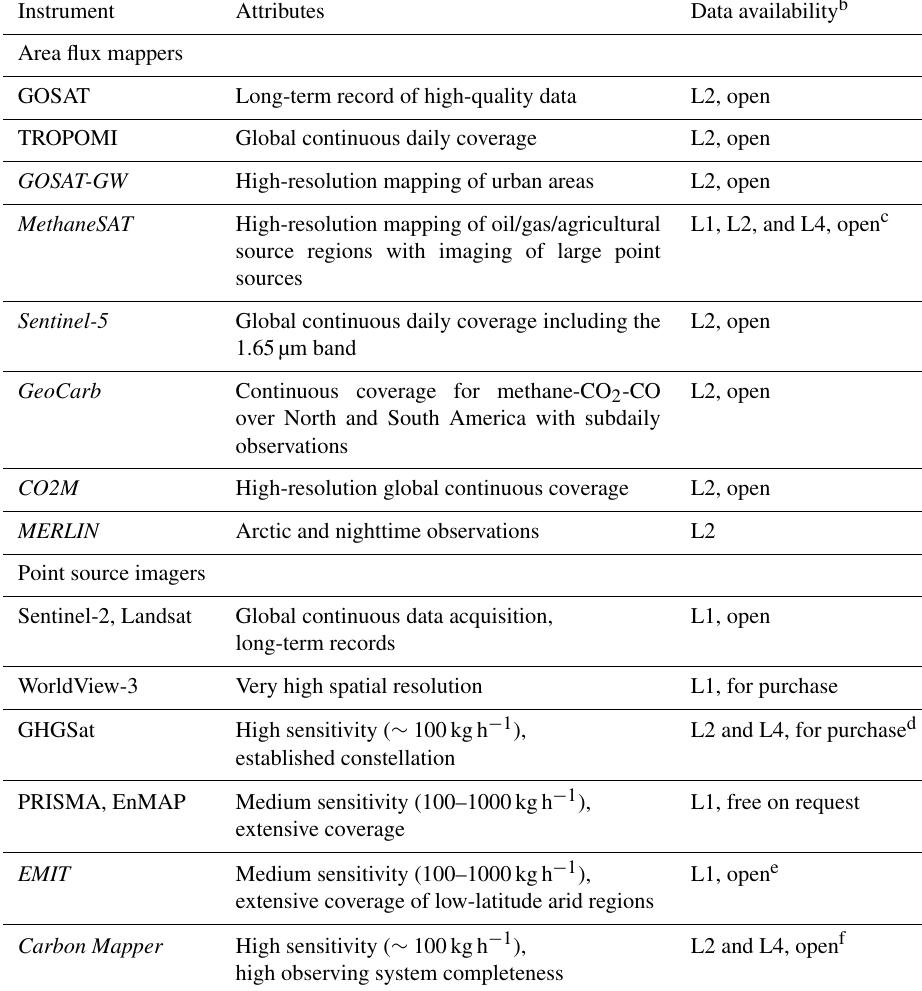
Table 2. Attributes and data availability for satellite instruments observing atmospheric methane a .